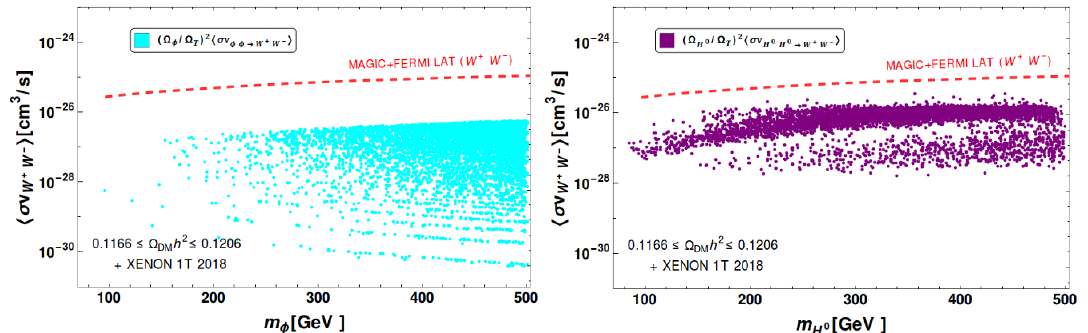
Figure 17 . DM annihilations (cid:30)(cid:30) ! W + W (cid:0) (left) and H 0 H 0 ! W + W (cid:0) (right) normalised by branching fraction of individual relic densities compared against the latest indirect detection bounds of Fermi-LAT [104].